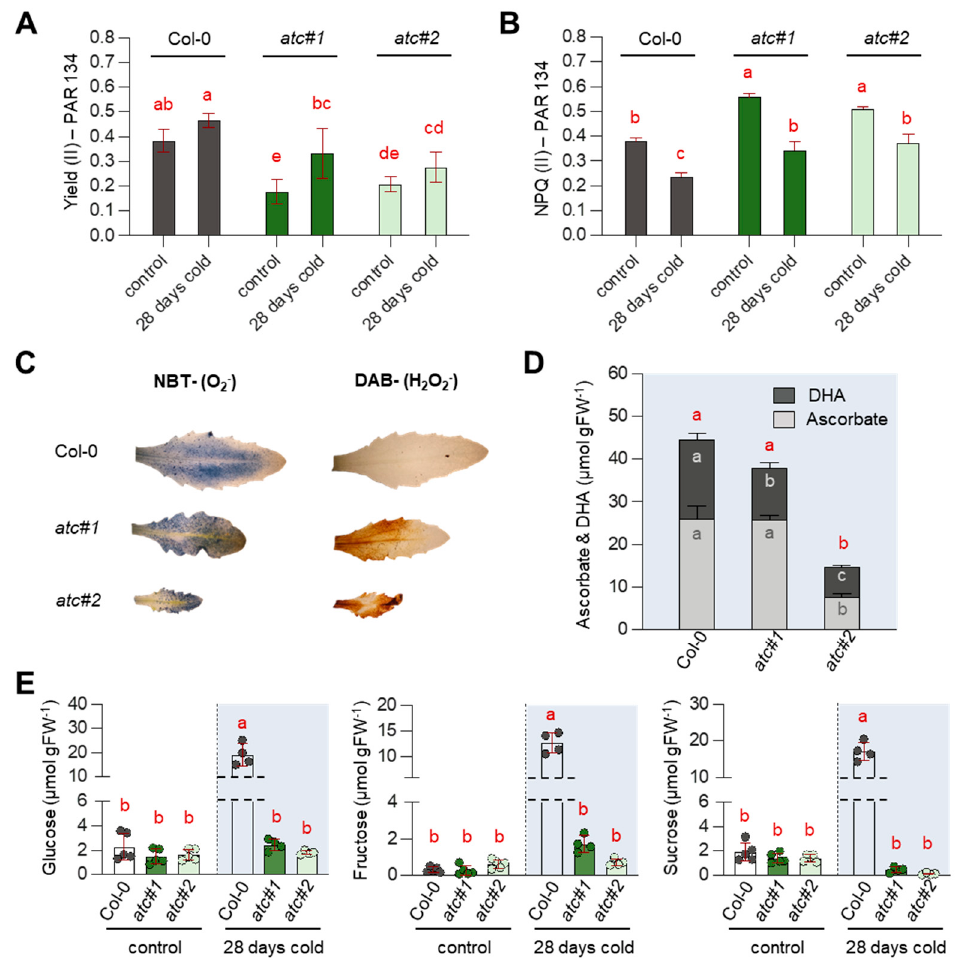
Figure 6. Determination of photosynthetic efficiency, accumulation of ROS, and sugar quantifica- tion. Plants were grown for two weeks at 22 °C before being transferred to 4 °C for the indicated times. ( A ) The effective quantum yield of PS (II) and ( B ) non-photochemical quenching (NPQ) were measured in a light response curve (n = 5). ( C ) NBT- and DAB-staining for visualization of reactive oxygen species showing typical results ( D ) measurements of Ascorbate and Dihydroascorbate (n = 5). ( E ) Quantification of glucose, fructose, and sucrose contents (n = 4). Data points are means +/ − standard deviation. Different letters denote significant differences according to a two-way ANOVA with post-hoc Tukey HSD testing ( p < 0.5).